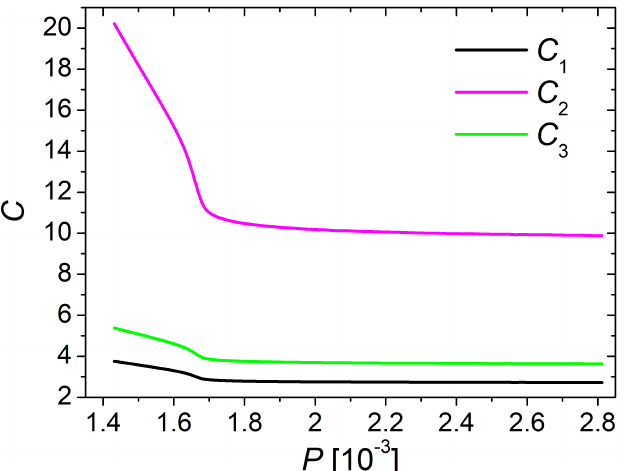
Figure 3. Behavior of the ratios C 1,2,3 of mean values (cid:104) η 3 (cid:105) , (cid:104) η 2 (cid:105) and (cid:104) η (cid:105) (see (29)) with varying internal pressure P .